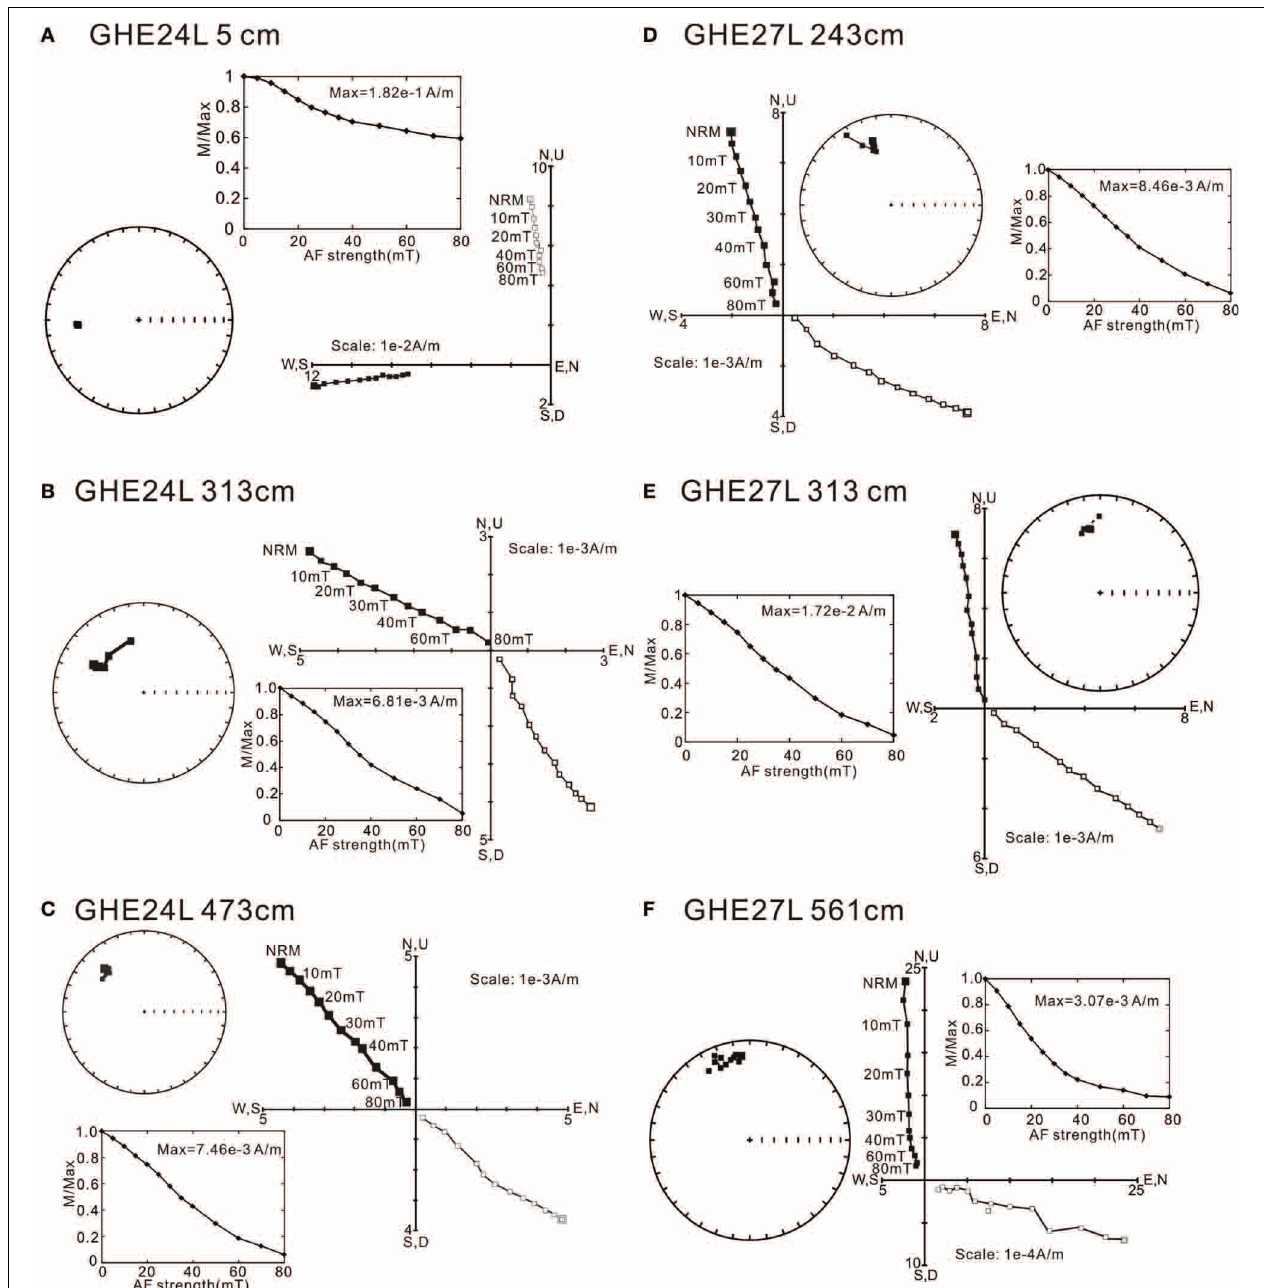
FIGURE 7 | Representative demagnetization data of Cores GHE24L (A–C) and GHE27L (D–F) sediments. Solid squares indicate the horizontal components and the open squares denote the vertical components.